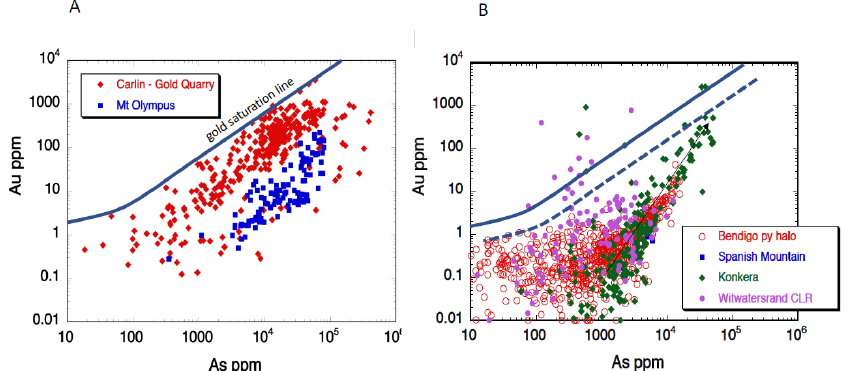
Figure 10. LA-ICPMS data plotted on the As-Au diagram for ( A ) Gold Quarry and Mt Olympus, ( B ) Bendigo pyrite halo, Spanish Mountain, Konkera and Witwatersrand CLR pyrite rims. The gold saturation line for the four deposits in panel ( B ), may be an order of magnitude lower (dashed line) than for Gold Quarry in panel ( A ) (solid line).